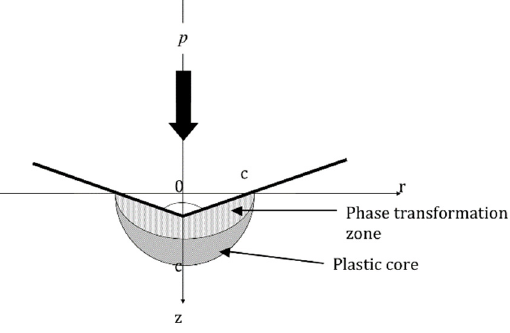
Figure 3. Schematic representation of the indentation-induced phase transition model; the phase- transformed zone is embedded within the plastic zone.